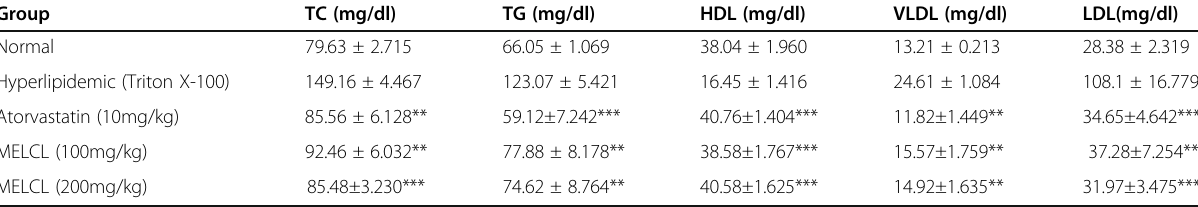
Table 2 Effect of methanolic extract of Luffa cylindrica (L.) leaves on Biochemical Parameters in wistar rats